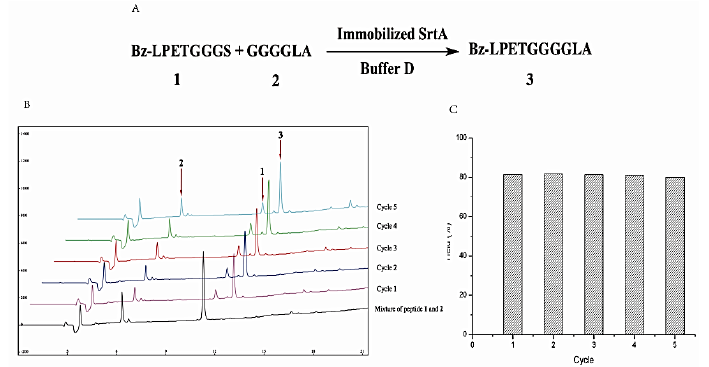
Figure 5. ( A ) Immobilized SrtA-mediated ligation of peptide 1 and 2 ; ( B ) HPLC diagraph of immobilized SrtA-mediated ligation of peptide 1 and 2 ; ( C ) Reuse and recycling of immobilized SrtA-mediated ligation of peptide 1 and 2 . Experiments have been performed in pH 7.5 at 37 °C for 1 h with ten chitosan-immobilized SrtA beads. Other specifications are described in Section 3.6.1.